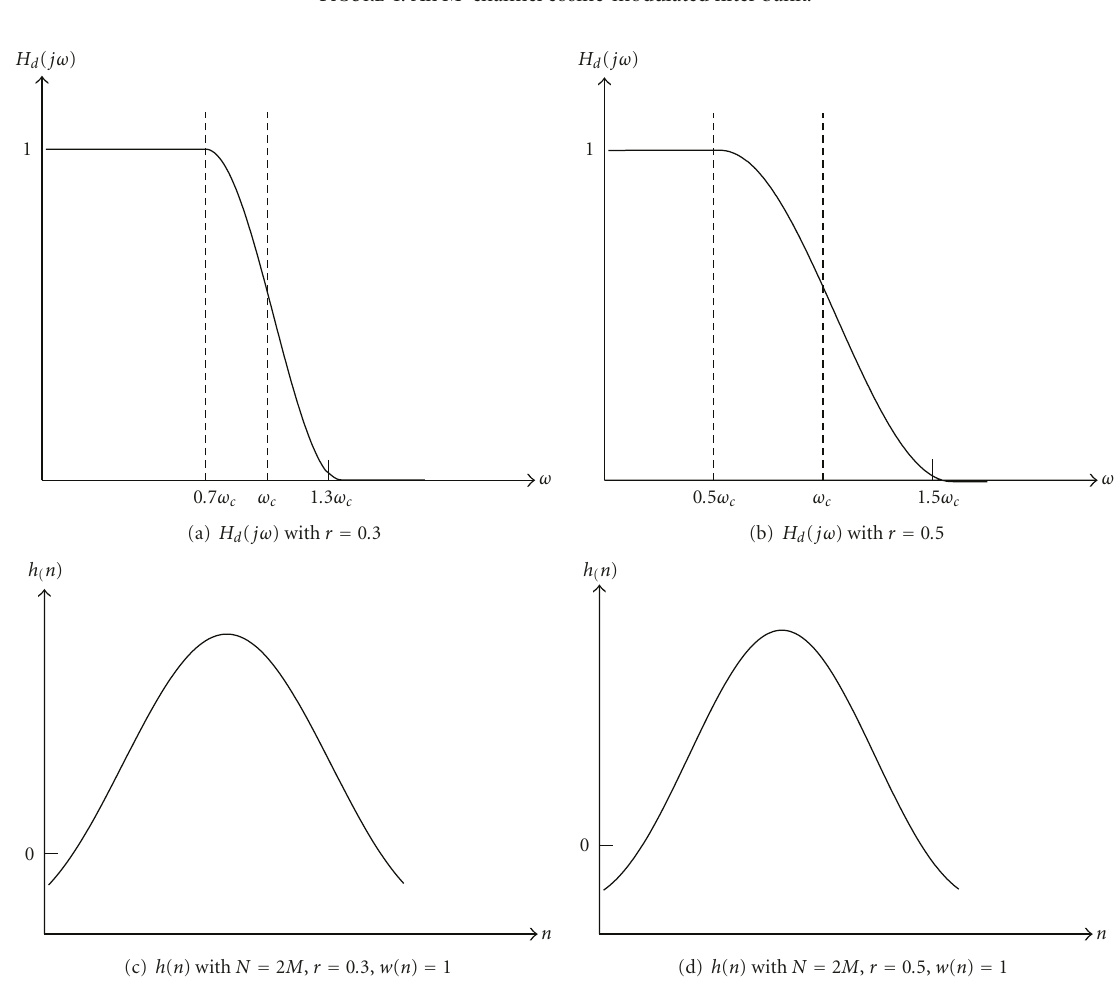
Figure 5: Examples of ideal prototype filter H d ( jω ) and its deduced prototype filter coe ffi cients h ( n ) at di ff erent roll-o ff factor r .